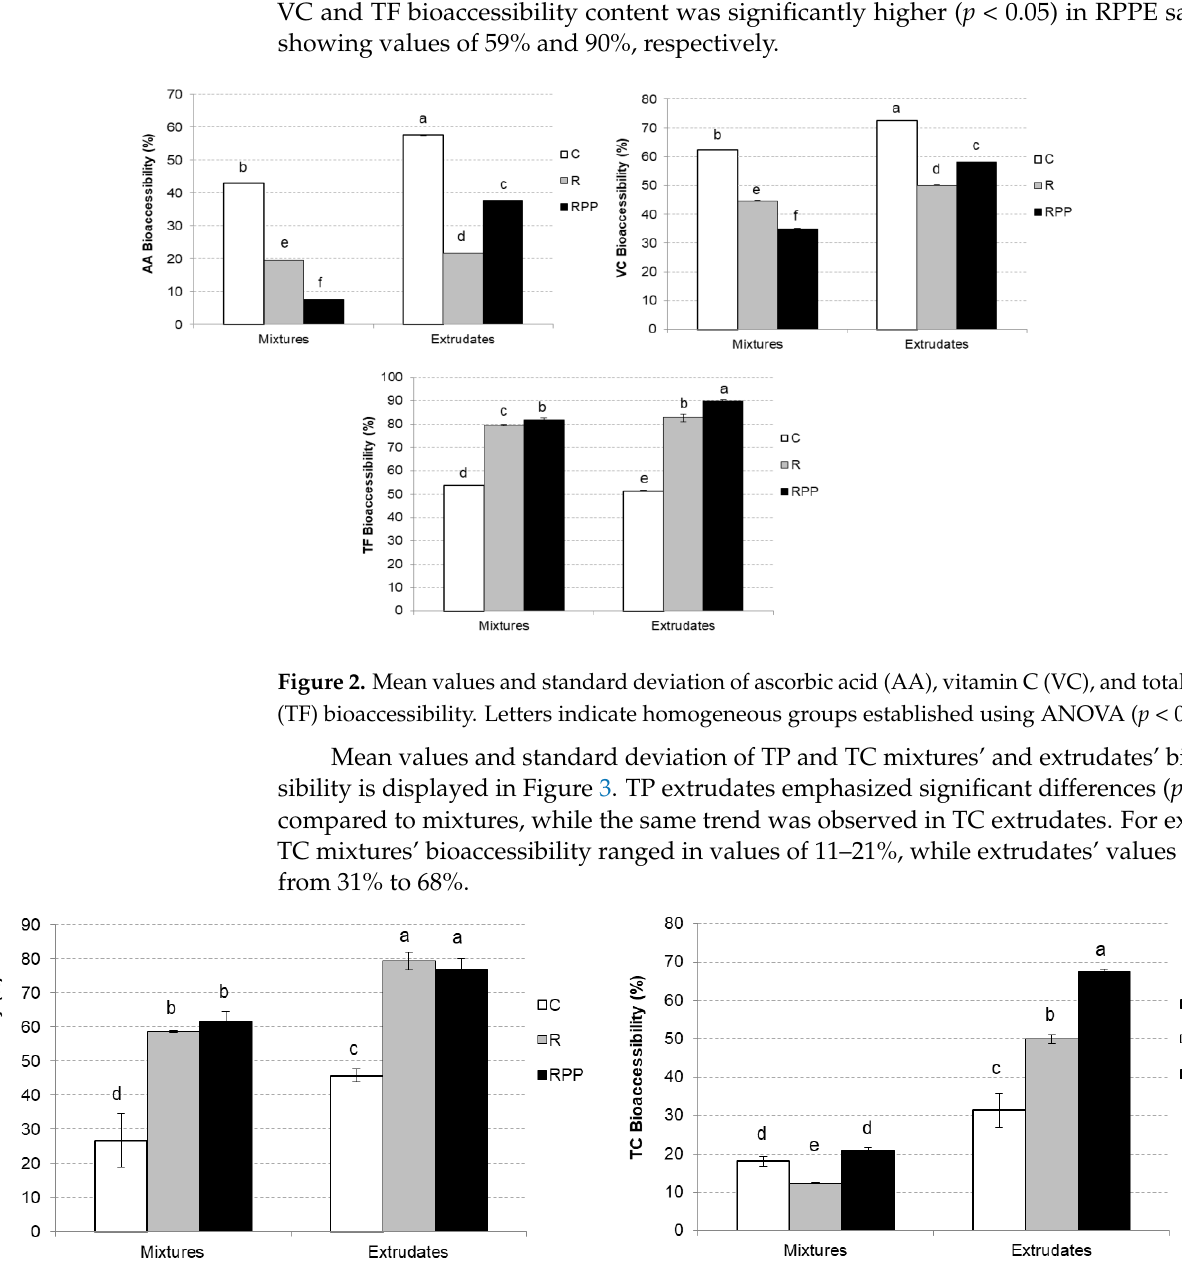
Figure 3. Mean values and standard deviation of total phenol’s (TP) and total carotenoid’s (TC) bioaccessibility. Letters indicate homogeneous groups established using ANOVA ( p < 0.05).